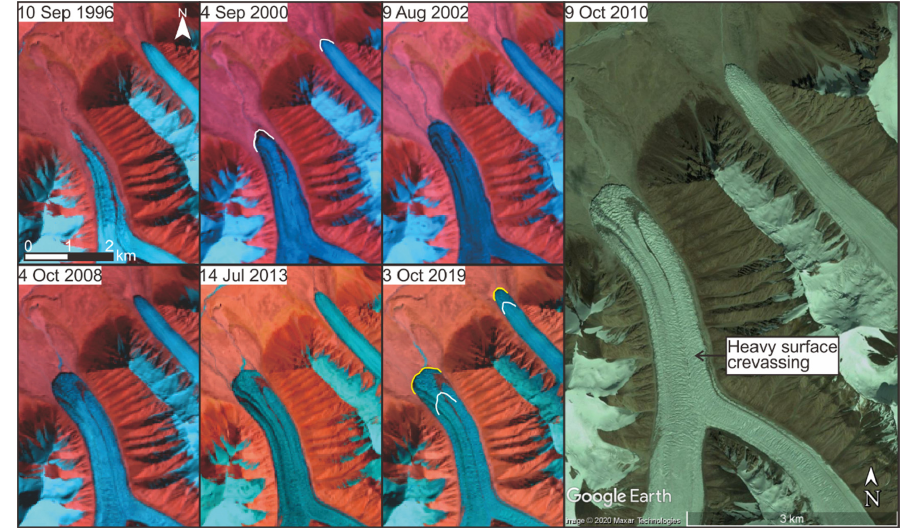
Figure 2. Satellite images of the two studied glaciers at different time. Six images on the left are false-color combination of Landsat series and the big image on the right is from Google Earth. The white and yellow lines, respectively, indicate the terminus positions in 2000 and 2019.